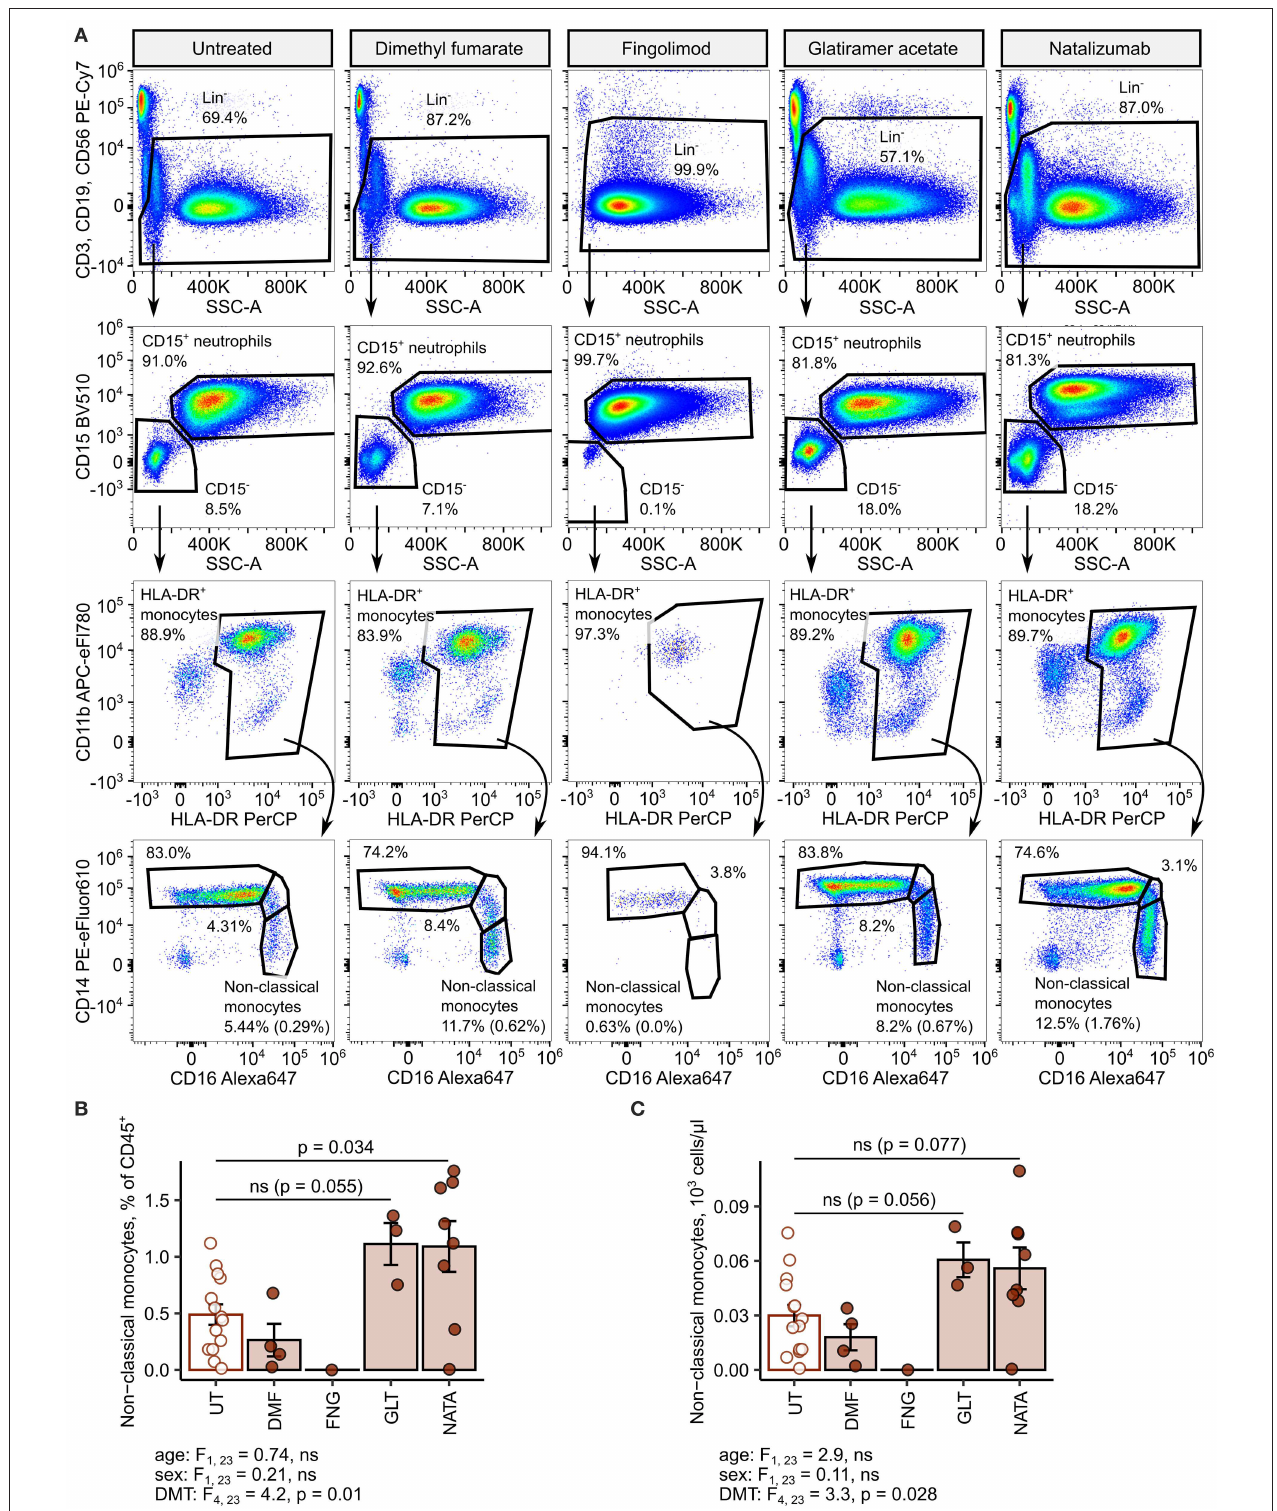
FIGURE 8 | Increased amounts of nonclassical monocytes in natalizumab-treated inactive relapsing-remitting multiple sclerosis (RRMS) patients. Nonclassical monocytes were identified in blood samples of inactive RRMS patients stratified by the kind of disease-modifying therapy [untreated (UT): n = 14, dimethyl